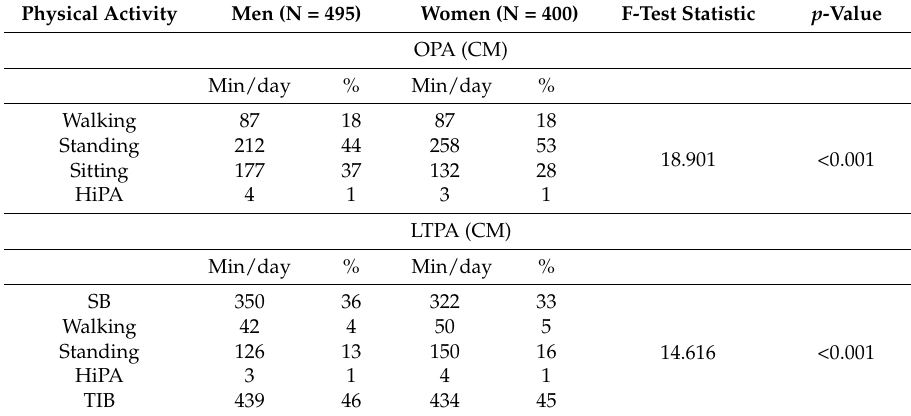
Table 2. Compositional mean for occupational physical activities and leisure time physical activities (in min/day and